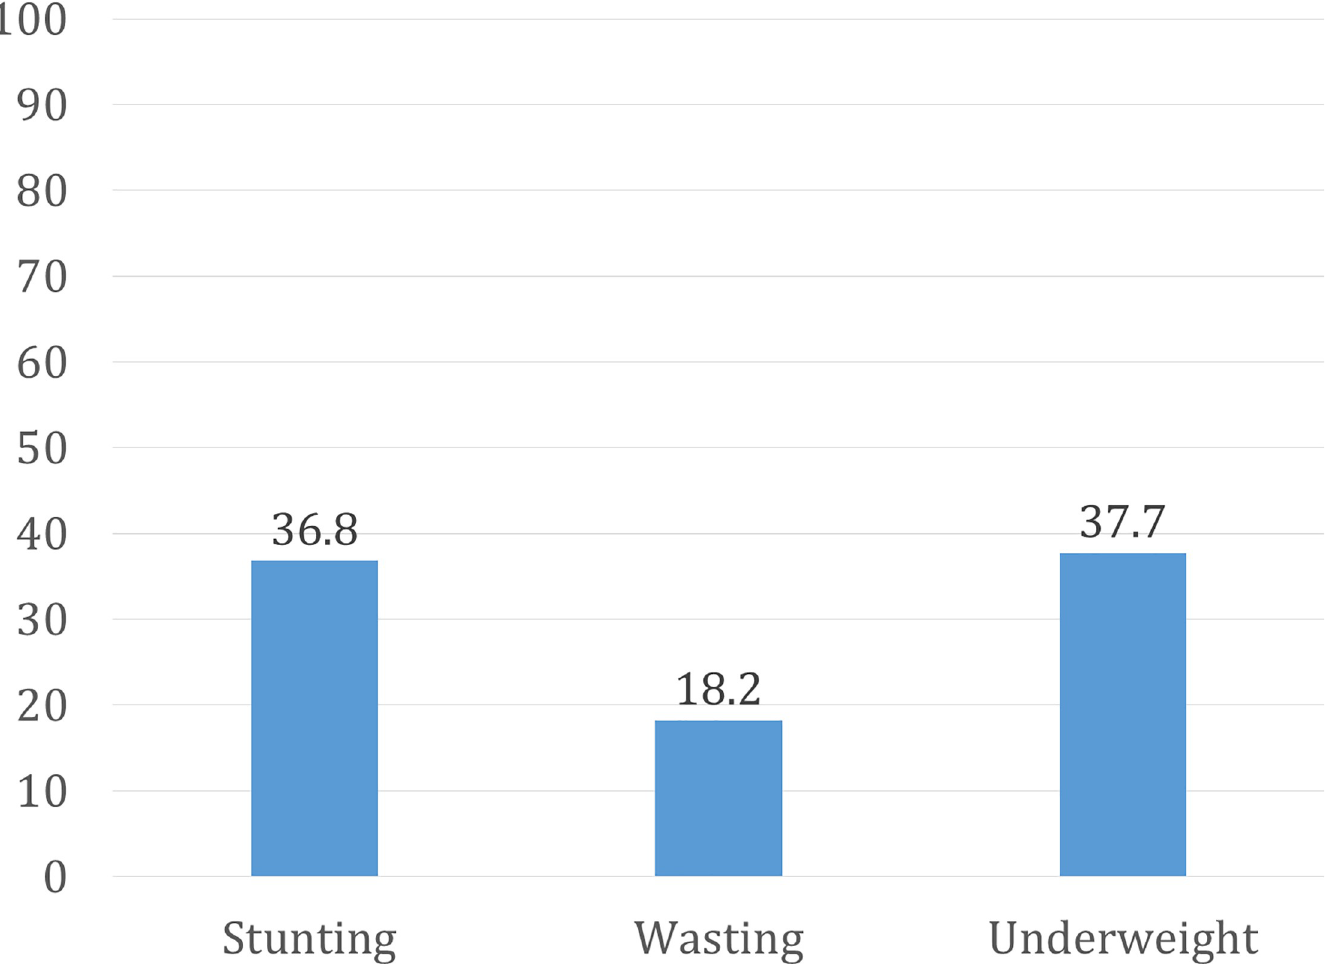
Fig 2. Prevalence of stunting, wasting and underweight among children aged 6-59months in rural areas of Bangladesh, 2014.